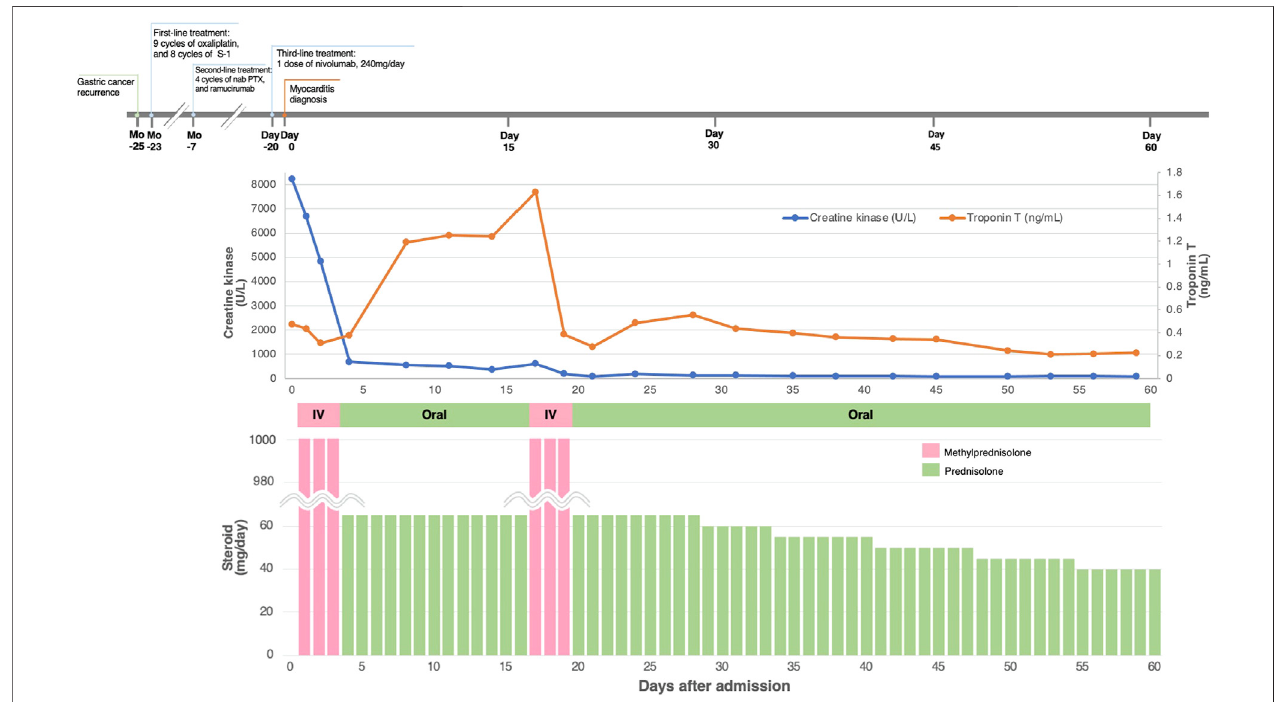
FIGURE 1 | Clinical course and changes in CK and troponin in case